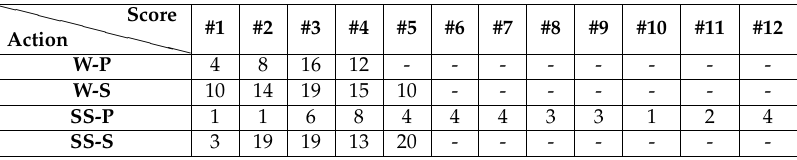
Table 2. Details of abnormality score ranges in the QMAR